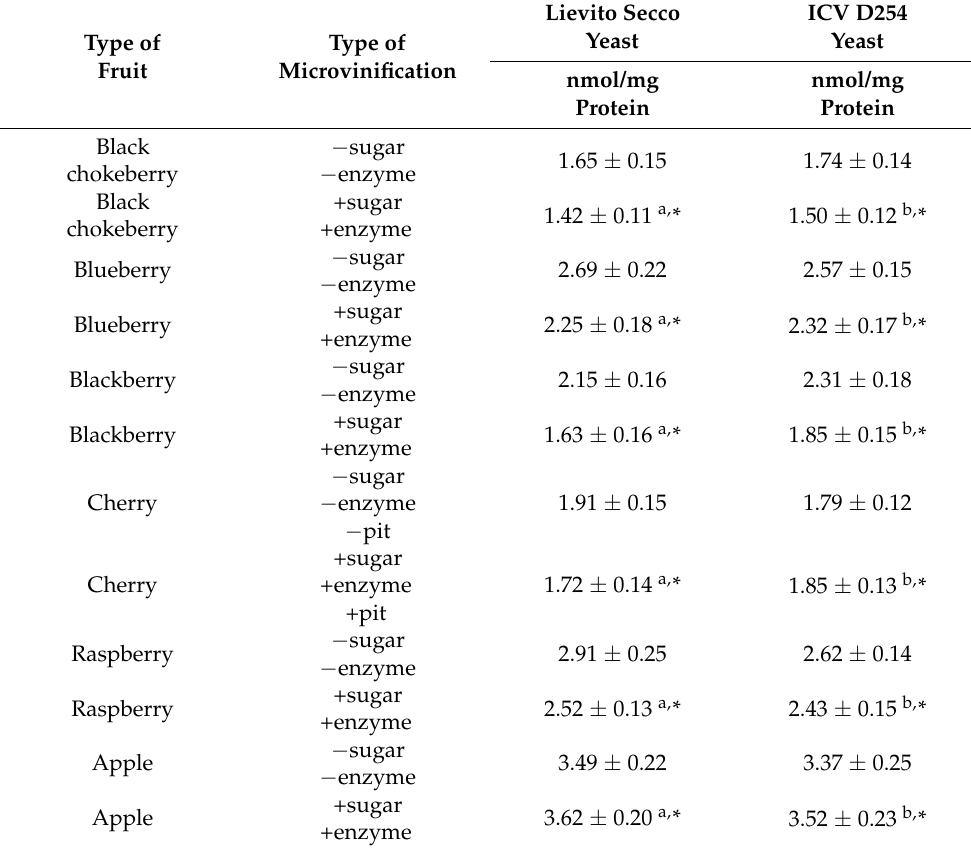
Table 4. MDA content (nmol/mg protein) in synaptosomes with H 2 O 2 -induced oxidative stress obtained in the presence of fruit wines produced by different types of